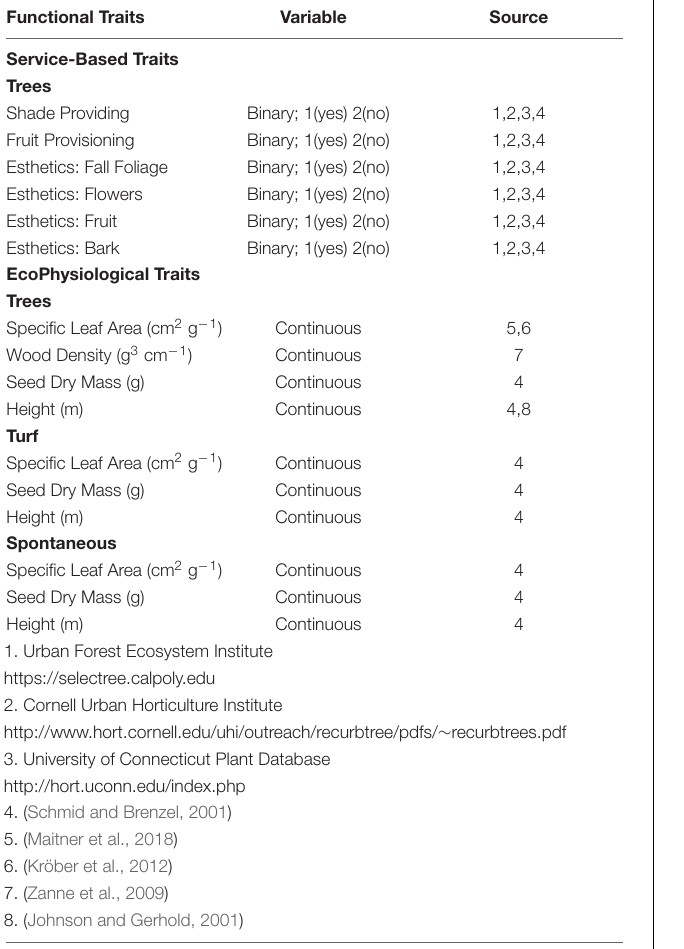
TABLE 2 | Functional traits used for analysis, grouped into “Service-based trait” and “EcoPhysiological” suites. Functional Traits Variable Source